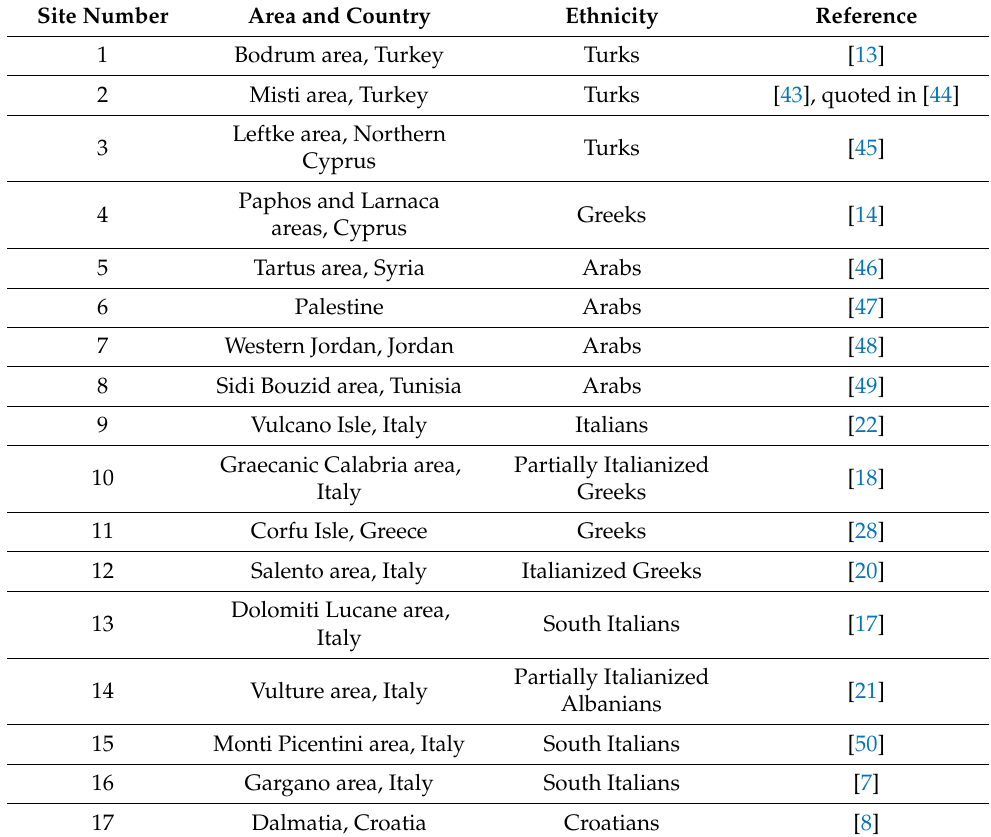
Table 1. Details of the ethnobotanical field studies on wild greens used for the comparative analysis (see Figure